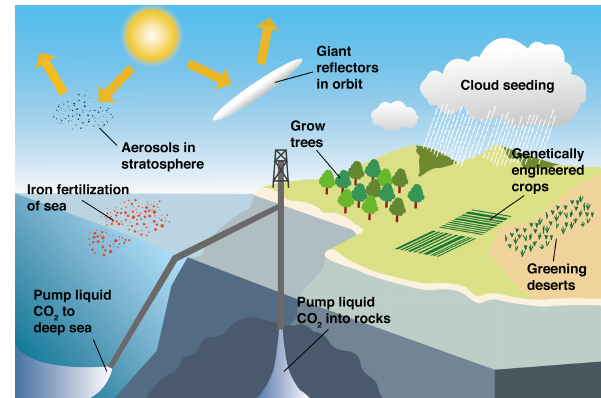
Figure 2. Schematic representation of several proposed climate- engineering methods (modified from Matthews,